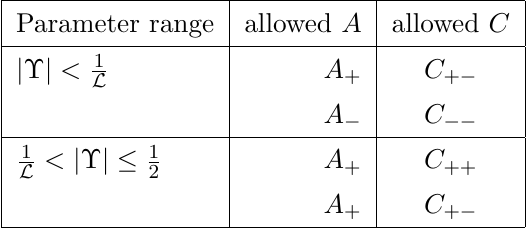
Table 2 . Allowed branches of solutions for di(cid:11)erent values of